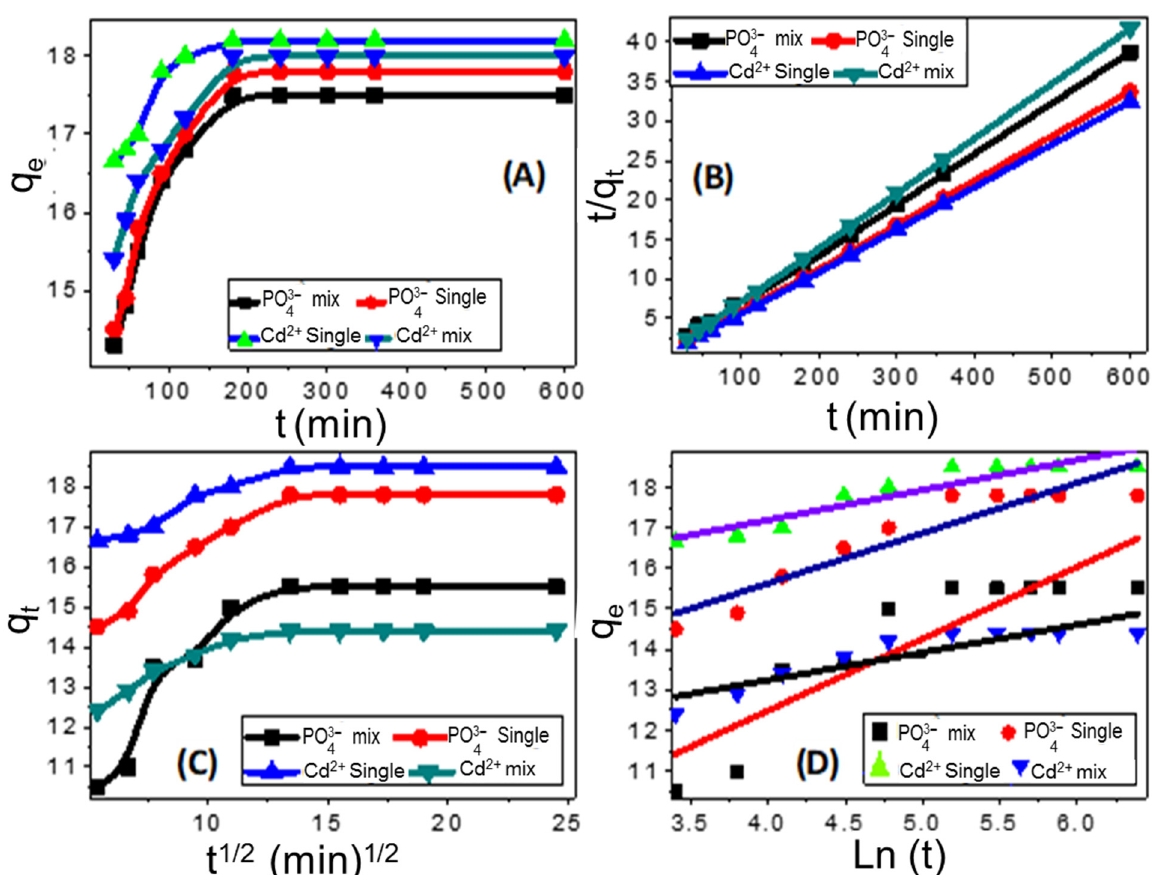
Figure 9. Kinetic studies of adsorption of Cd 2+ and PO 43 − by nanocomposite; the relation between the contact time and uptake capacity ( A ), plot for the second-order model ( B ), plot for intra-particle diffusion model ( C ), and plot for Elovich kinetic model ( D ).